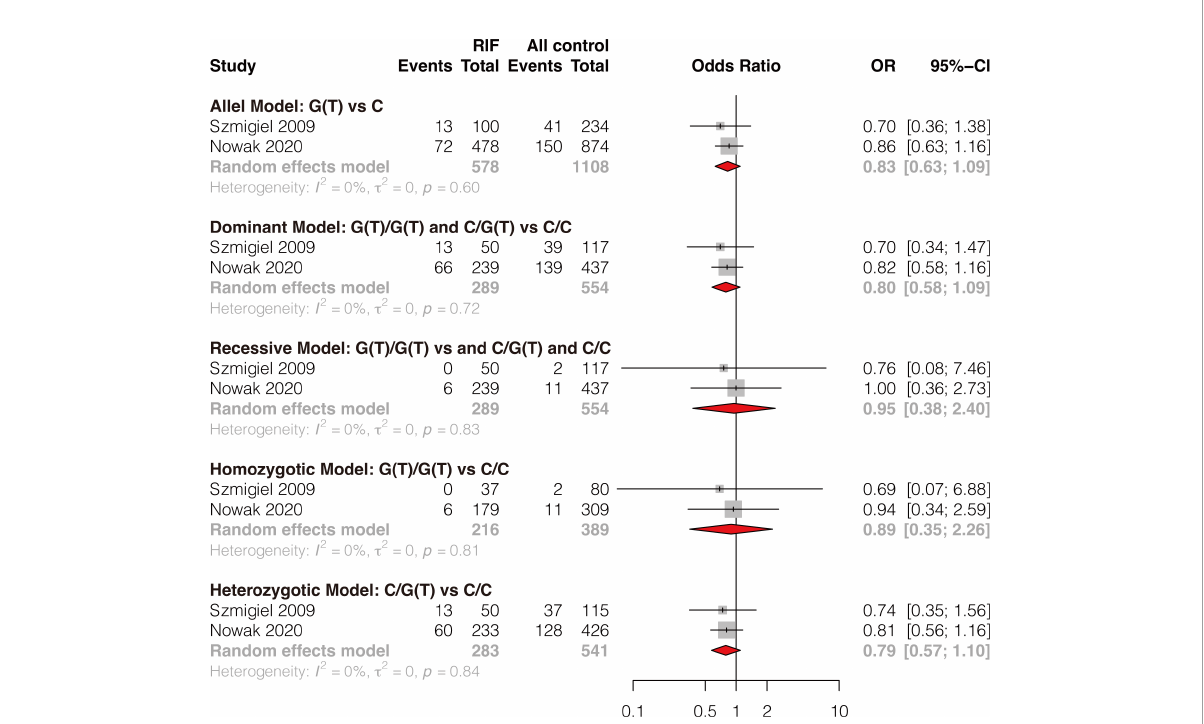
FIGURE 4 Forest plot showing the association of HLA-G -725C>G/T polymorphism with RIF under 5 genetic